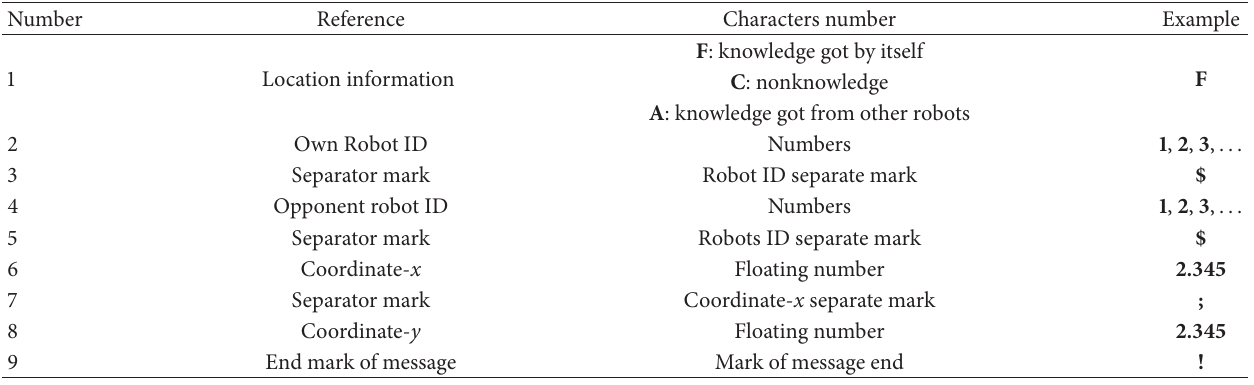
Figure 5: AMiR returning from charging station. Table 3: Illustration of code used in the message format.